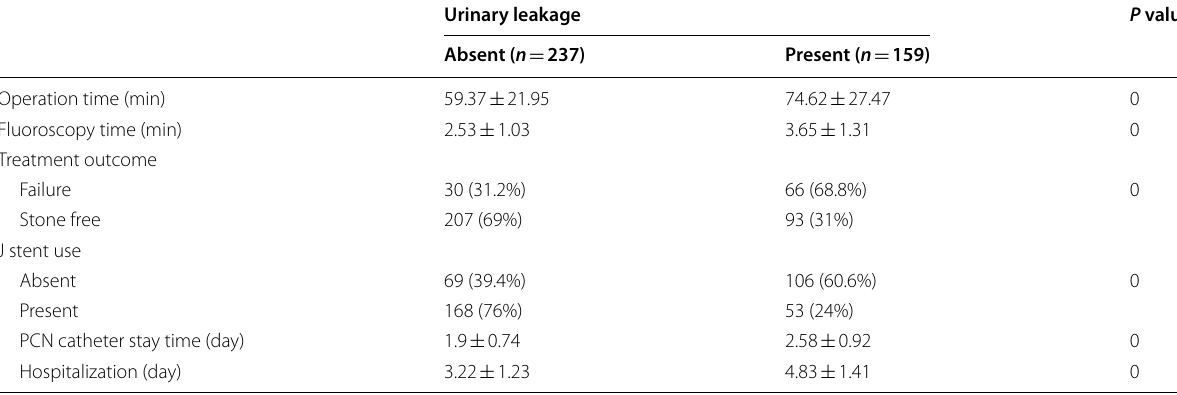
Table 3 Impact of surgery related factors on urinary